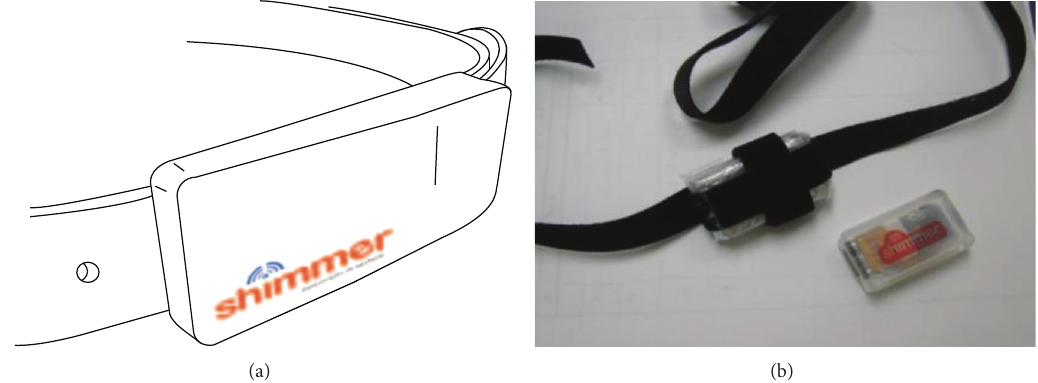
Figure 4: Shimmer integrated into a belt buckle (a). Shimmer attached to a Velcro stripe (b).